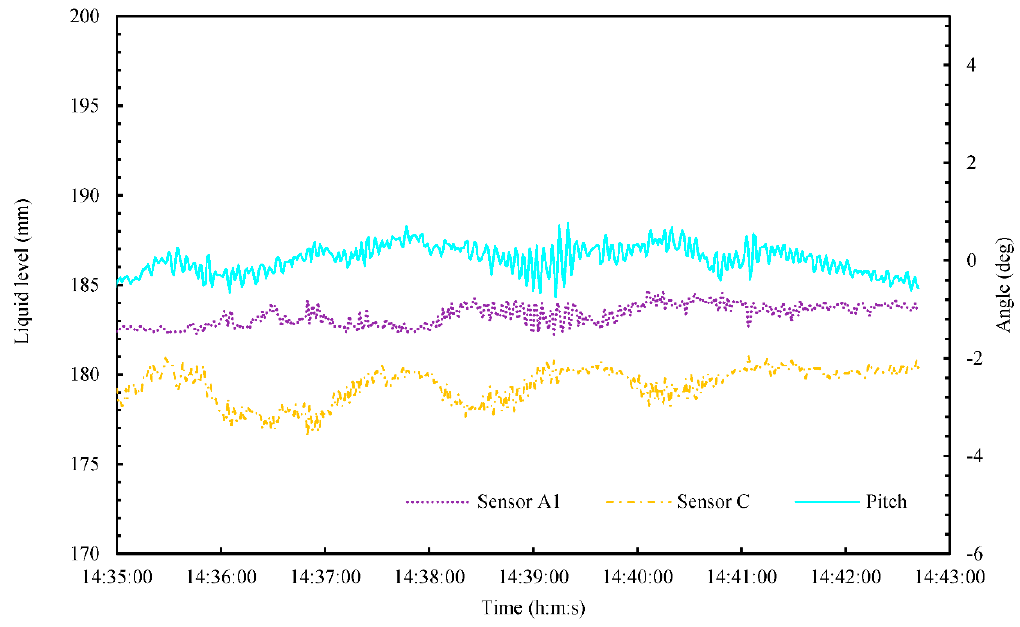
Figure 12. Time series of the liquid level and rolling angle during a zigzag maneuver from 14:35 to 14:42.